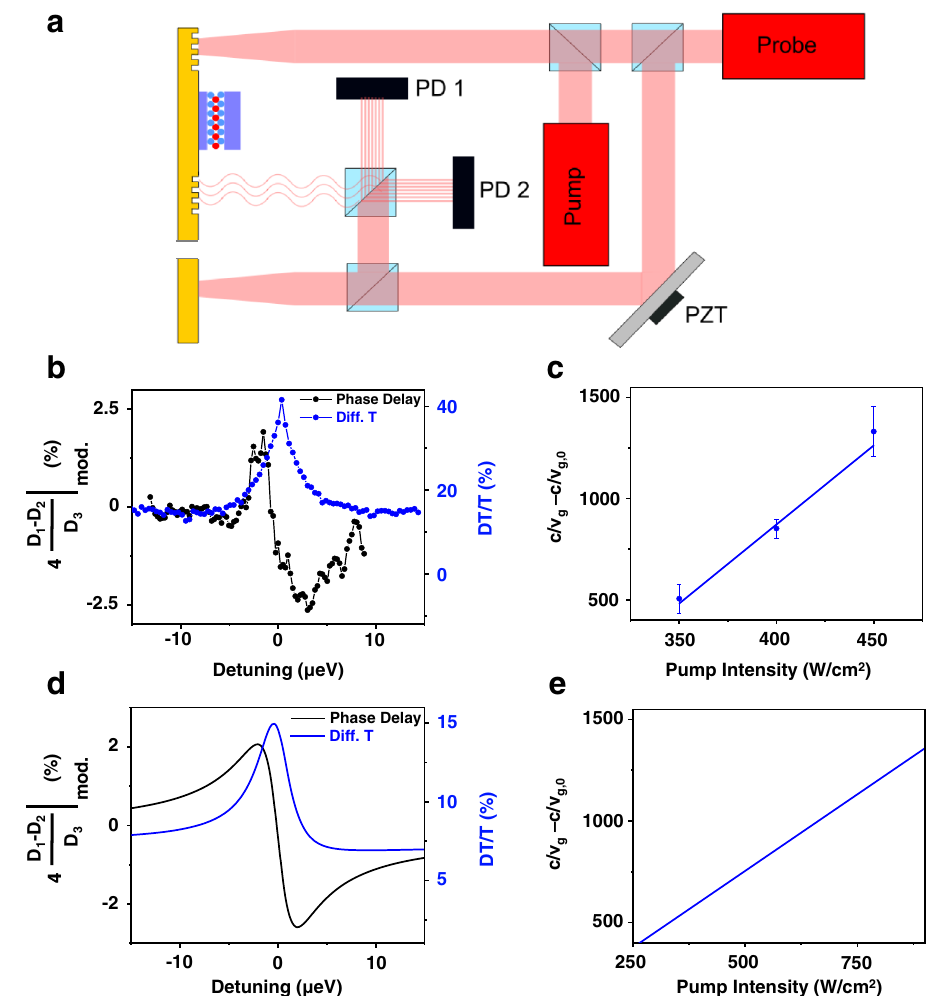
Fig. 3 | Slow light via coherent population oscillations (CPOs). a Depiction of the slow-light measurement. The probe is split off before the sample to create a reference beam path for one arm of the Mach – Zehnder interferometer (MZI). The reference beam path has a piezo translator (PZT) to control the phase of the het- erodynesignalmeasuredfromphotodiodes1and2( D 1 , D 2 ). b Pump-inducedphase delayMZIsignal(black)fromtheCPOfor100 μ Wprobeand400 μ Wpumppowers. The raw signal is scaled by a factor of 4 due to the modulation (subscript “ mod ” ) schemeused(seeSupplementaryNote3).Thenormalizeddifferentialtransmission (Diff. T) shown in blue shows the corresponding CPO DT/T resonance. c